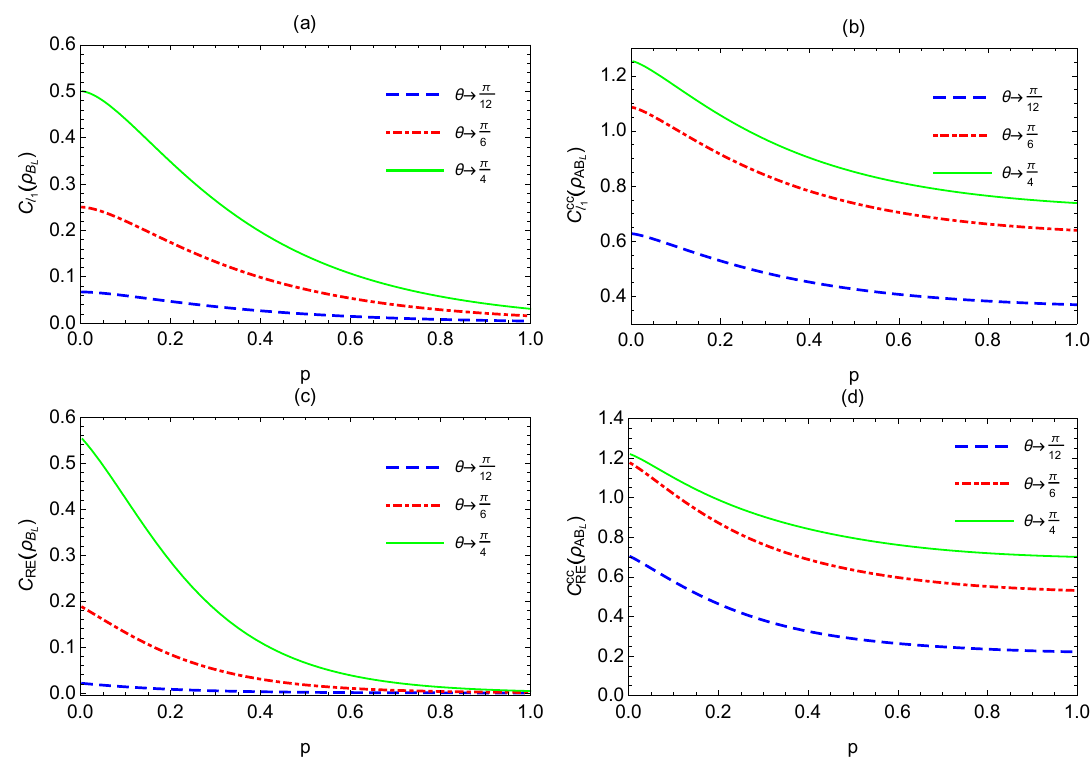
Figure 3 . Local quantum coherence and correlated coherence of state ρ AB curvature parameter p for different θ . The mass parameter ν is fixed as ν = 1 / 2 .